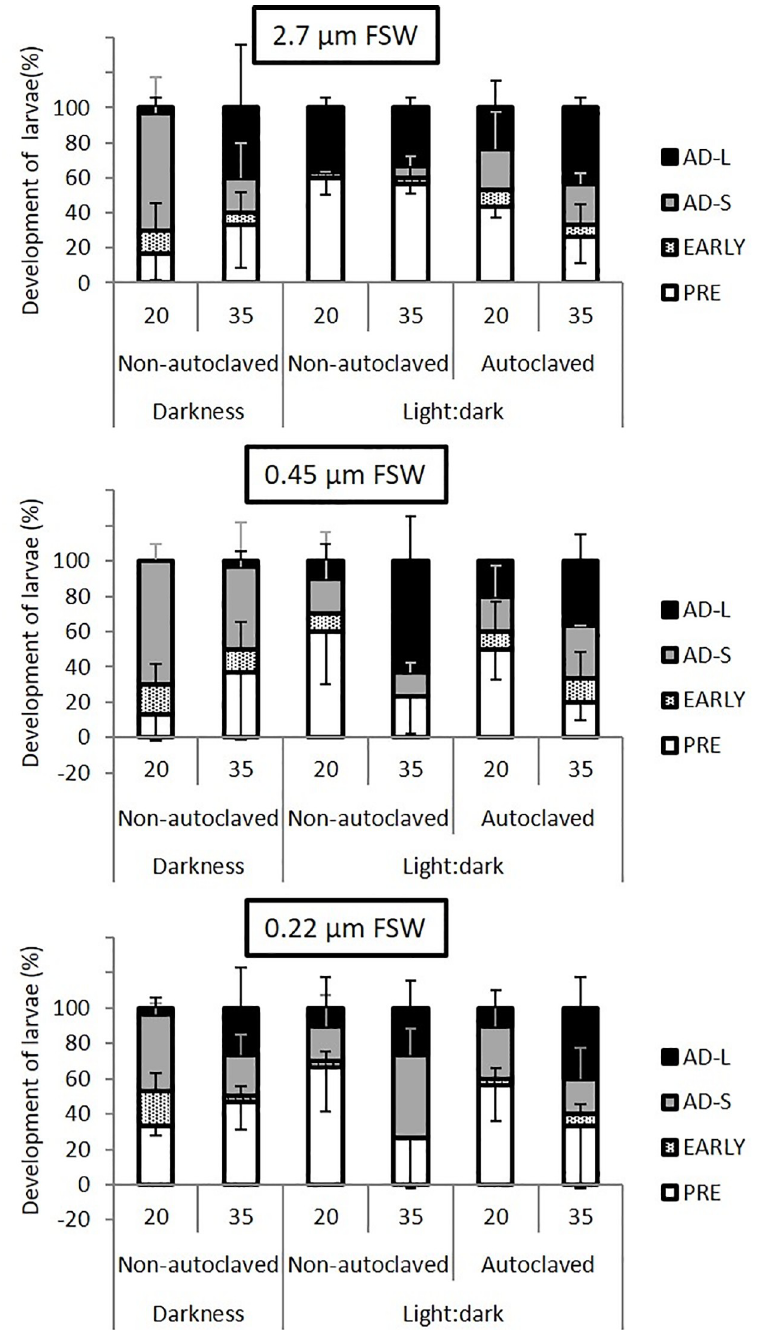
Fig 5. Development stages achieved by Rhytisma fulvum fulvum on days 20 and 35 of culture under different water treatments and light conditions. Cultures are the same shown in Fig 3. Data are presented as percentage of total (n = 3, 10 larvae per culture unit, no dead larvae observed during the period). Planulae were classified into pre- metamorphosed (open bars), early metamorphosed (striped bars), advanced metamorphosed with short tentacles (AD-S, grey bars) and advanced metamorphosed with long tentacles (AD-L, black bars). Data are shown as means ± S. D. (n = 3, 10 planulae per replicate).